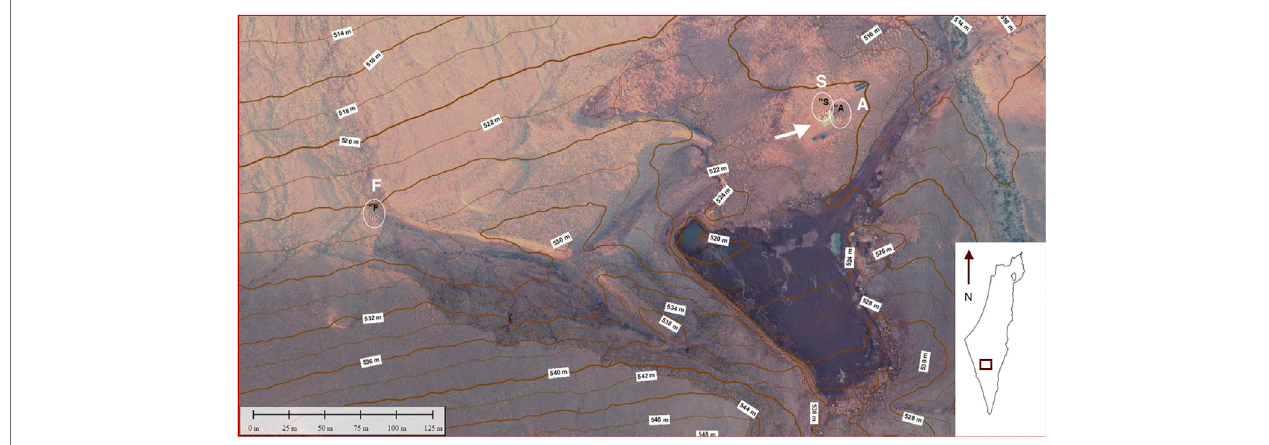
FIGURE1| Anorthophotoandelevationmodelofthehabitatandthesamplingsites.Sitesarehighlightedwithwhitecircles.SiteAisdenoted “ A, ” siteFisdenoted “ F ” and site S is denoted “ S. ” The white arrow points toward the habitat. Small inset shows the general location of the experiment in Israel, Ramon Crater.